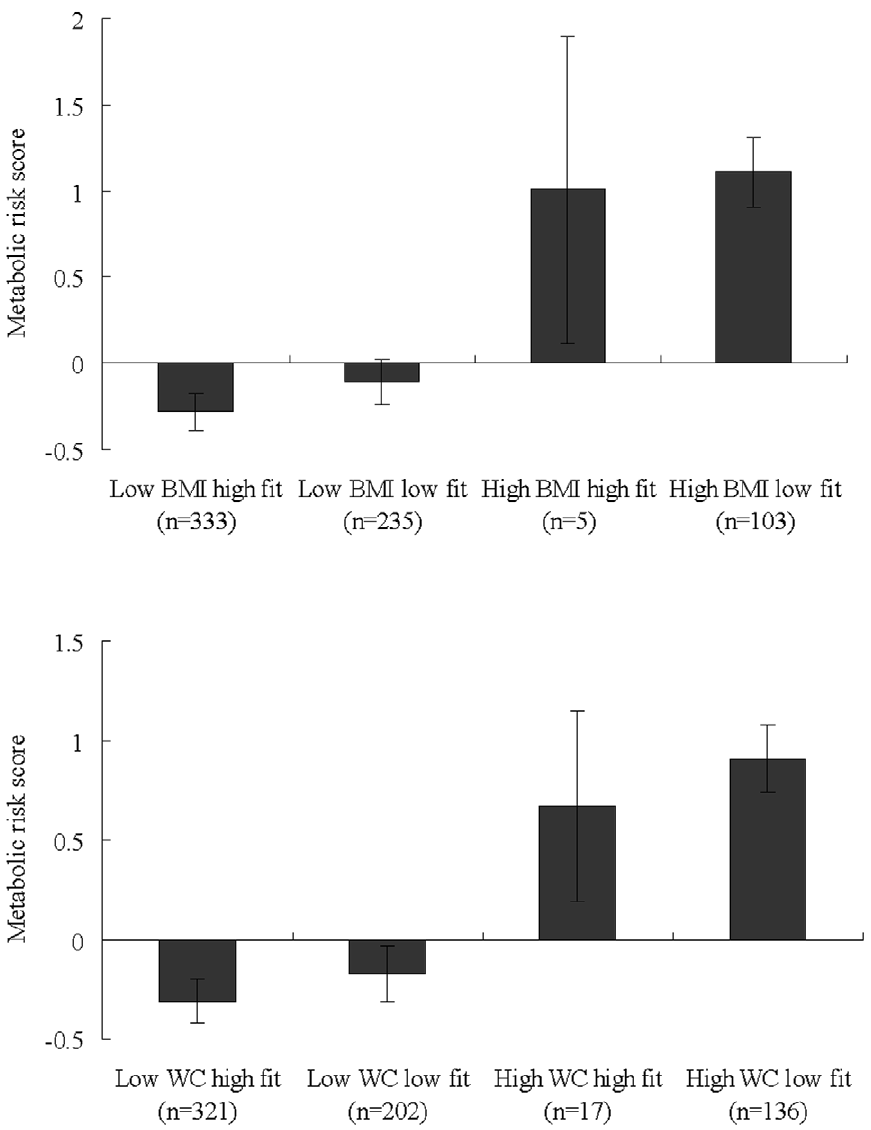
Figure 1. The relationship between fitness, body fat, and MRS in boys and girls. doi:10.1371/journal.pone.0027896.g001 PLoS ONE |